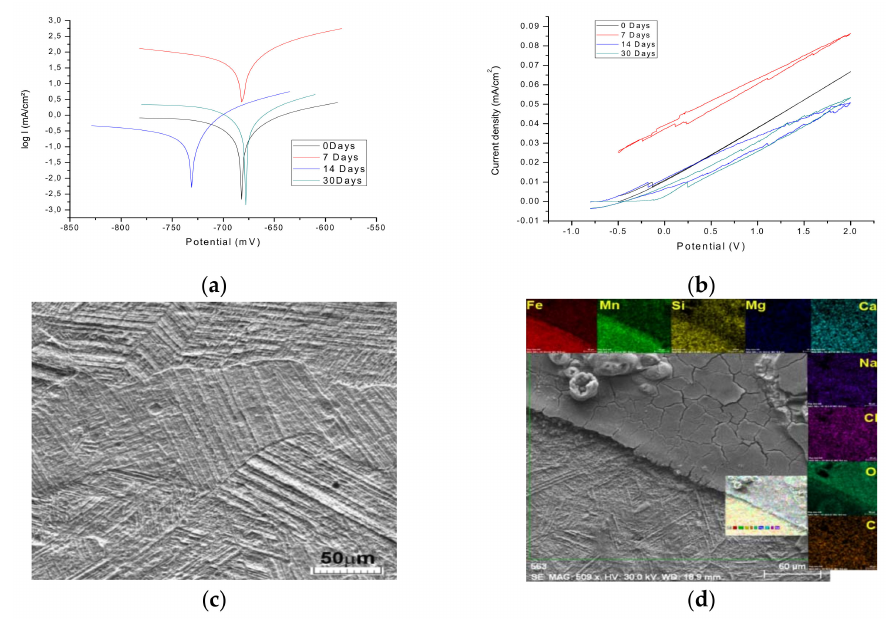
Figure 5. Linear polarization: ( a ) Tafel diagrams of the experimental alloy behavior; ( b ) cyclic diagrams of the experimental alloy behavior; ( c ) surface statement after the electrochemical corrosion test; and ( d ) chemical element distributions on the corroded